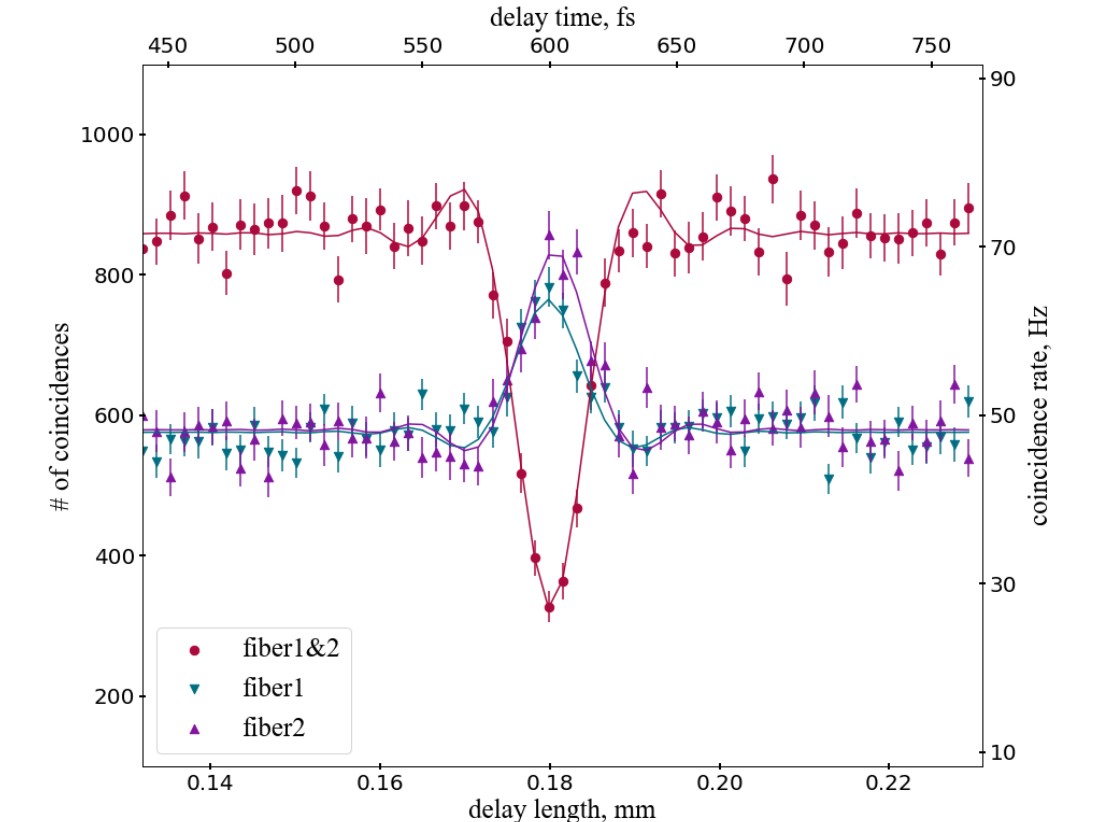
Figure 10. Number of coincidences between two different fibers (fiber 1&2) and within the same fibers (fiber 1, fiber 2), shown for experimental data and corresponding fits as function of the delay between two photons. The delay is expressed in mm (bottom horizontal scale) and in fs (top horizontal scale). The HOM dip is obvious around the delay value of 0.18